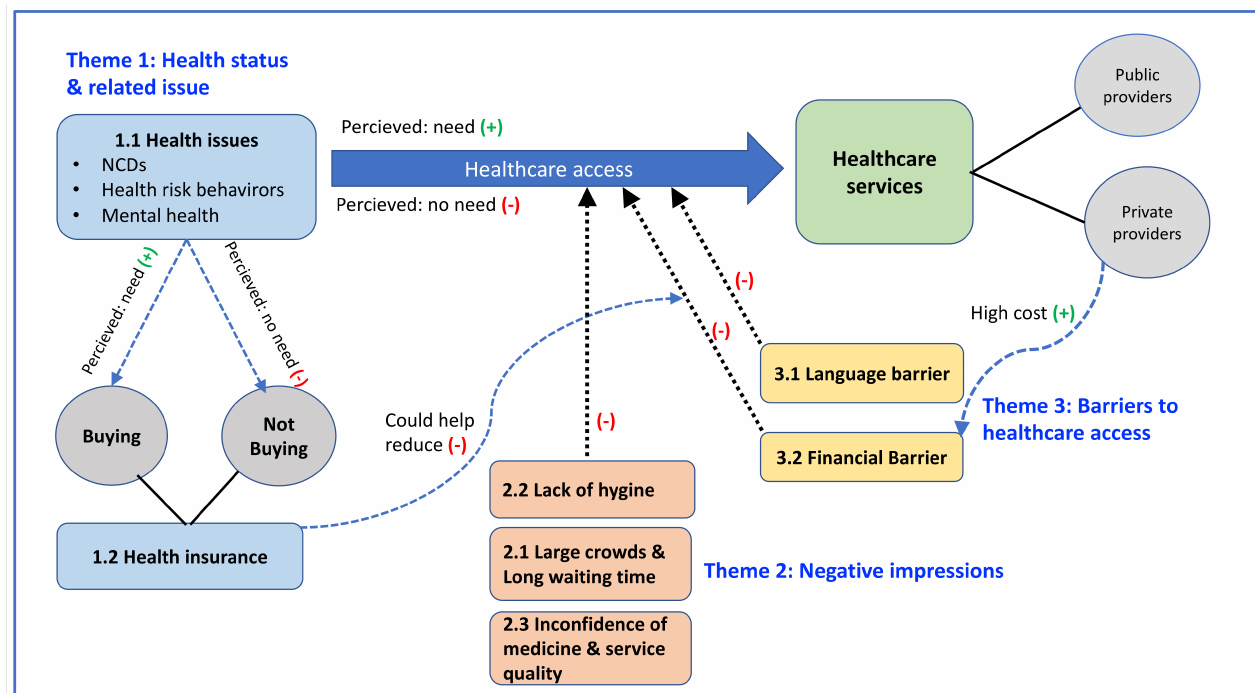
Figure 2. Summary of the study